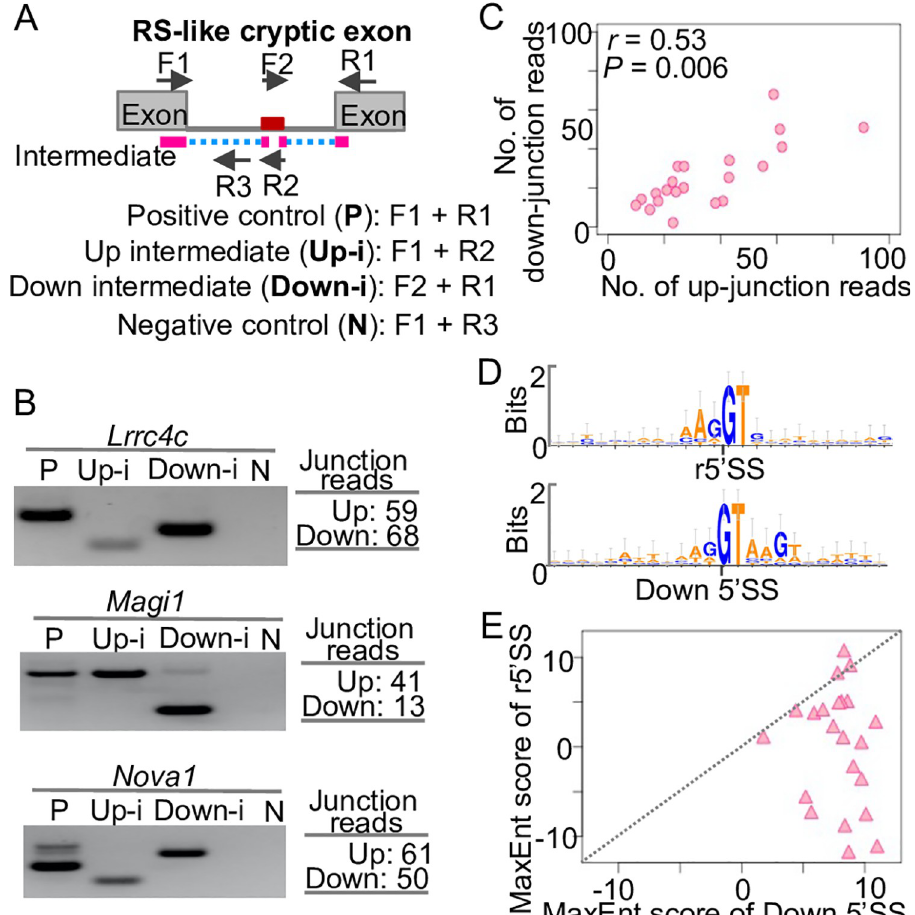
Fig 5. Cryptic exons use a RS-like splicing mechanism. (A) Schematic of RS-like cryptic exons and the primer design. (B) Validation of the upstream (Up-i) and downstream (Down-i) splicing intermediates using RT-PCR. P, positive control. N, negative control. Left, RT-PCR and gel results. Right, numbers of junction reads from the nuclear total RNA-seq data. (C) Scatter plot of the numbers of up- and down-junction reads of the RS-like cryptic exons. (D) Sequence logos of the r5’SS and Down 5’SS of the RS-like cryptic exons. (E) Scatter plot of the MaxEnt scores of the r5’SS and Down 5’SS of the RS-like cryptic